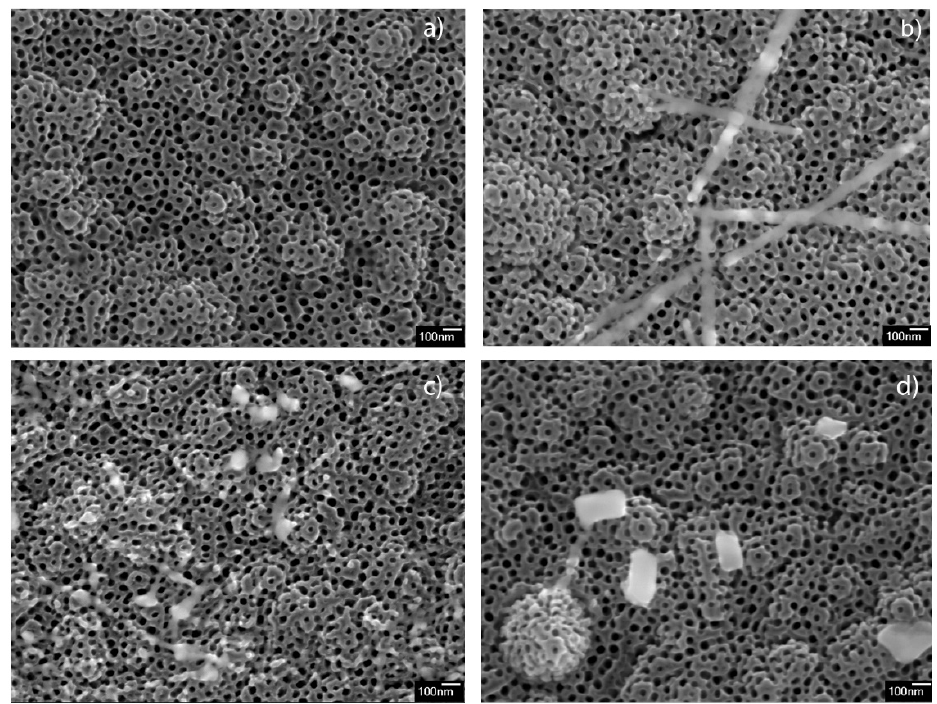
Figure 1. FE-SEM 50 kx magnification micrographs of ( a ) unmodified TNT, and Ba-modified samples: ( b ) 12.5 mM_BTNT, ( c ) 25 mM_BTNT, ( d ) 50 mM_BTNT.